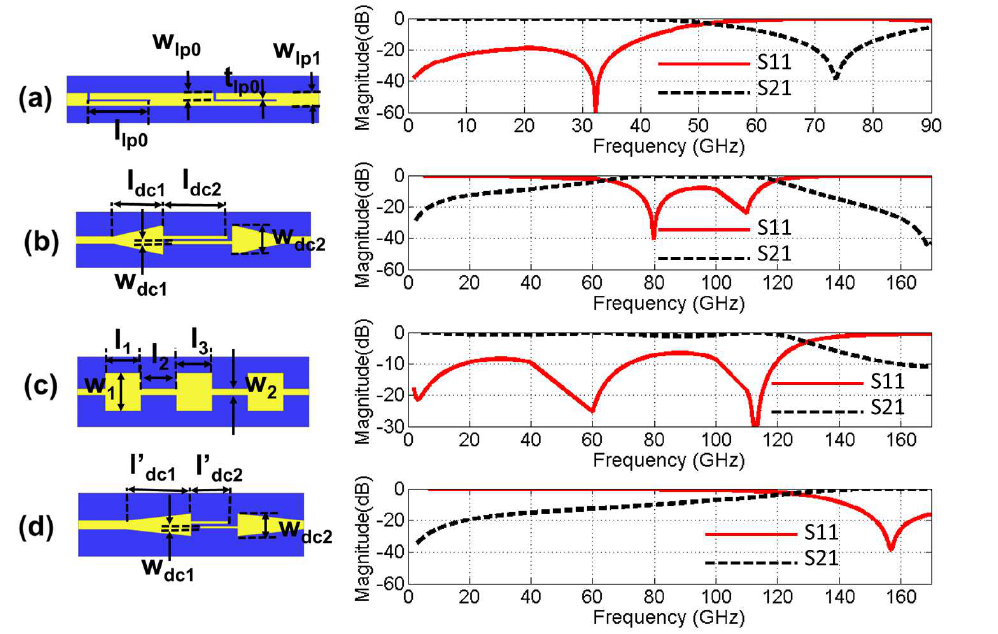
Figure 4. Top view and predicted response of the frequency doubler passive circuits: ( a ) Low pass filter for DC-Bias, ( b ) DC-Block 1 for IN frequency, ( c ) Stepped impedance low pass filter (LPF1) and ( d ) DC-Block 2 for LO